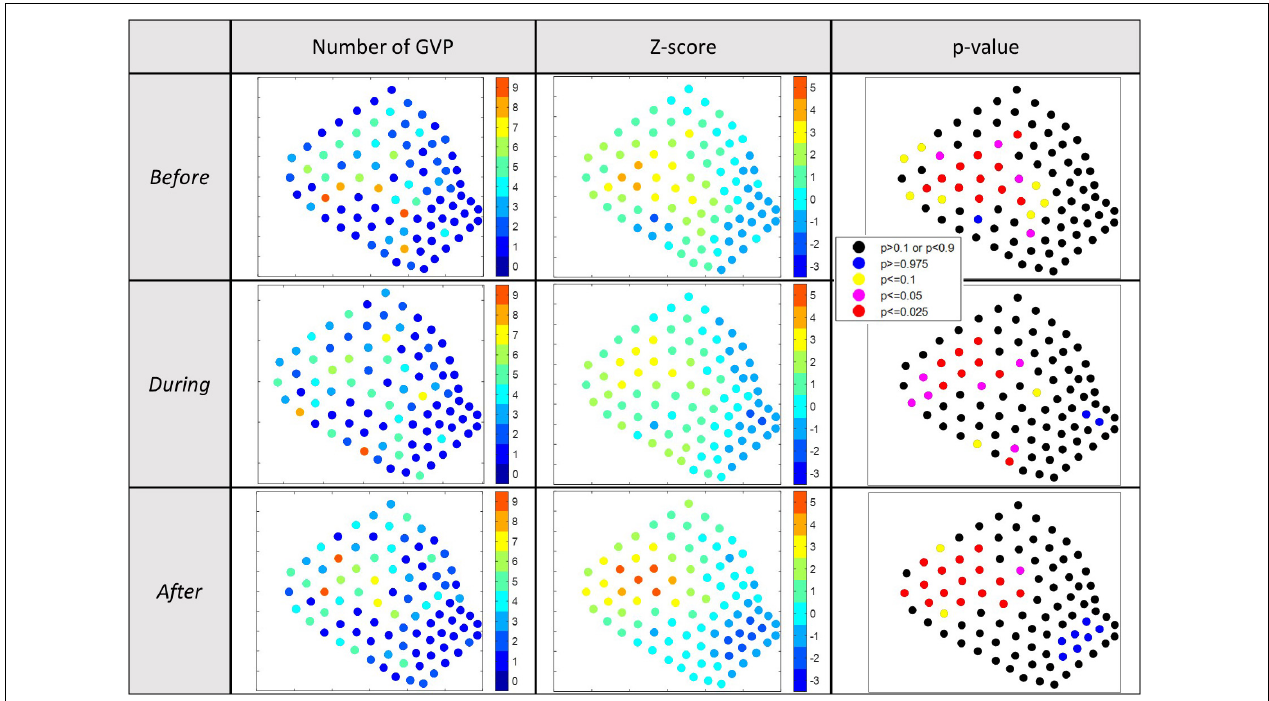
FIGURE 4 | Results of the 2017 Gi* analysis for local hot/cold spots. Column 1: visual depiction of the number of GVPs by hydrophone; column 2: visual depiction of the Gi* z-values by hydrophone; column 3: visual depiction of the p -values associated with the Gi* results by hydrophone. p < 0.025 were considered relative hot spots, whereas p > 0.975 were considered relative cold spots. Each row represents a different analysis period: top- Before ; middle- During ; bottom- After .